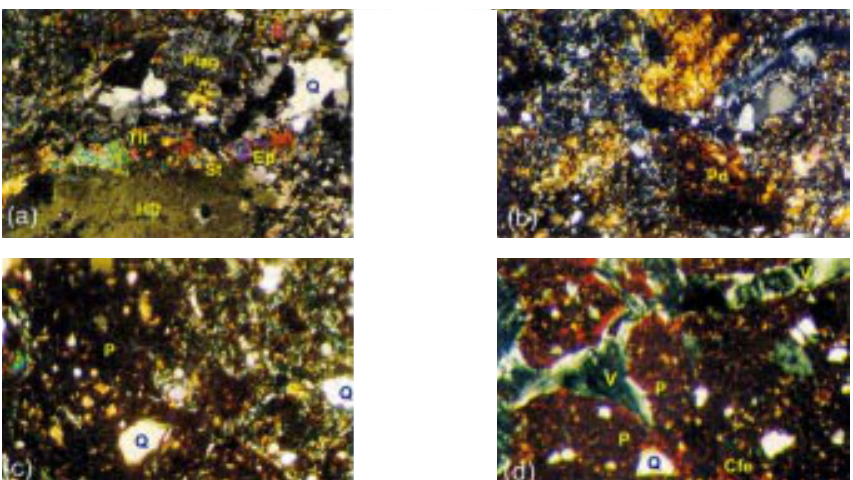
Figura 2. Microfotografias ao longo do perfil 2 - Argissolo Vermelho. (a) Fácies rocha fresca (HD = hornblenda- edenita; Plag = plagioclásio, Q = quartzo, Ep = epidoto, St = sericita e Tit = titanita); (b) Fácies alterito- (Pd = pseudomorfos de HD, processos de argilização e ferruginização); (c) Fácies de horizonte C 3 transição-horizonte BC, evolução dos processos de argilização e ferruginização (Q = quartzo, P = plasma); (d) Fácies sólum-horizonte Bt (Q = quartzo - esqueleto, V = vazios, P = plasma a argilominerais silicatados + sesquióxidos de Fe e Al, Cfe = cutans - ferriargilans, indicativo de processo de iluviação). (Obj 6.3x; Oc 8x).